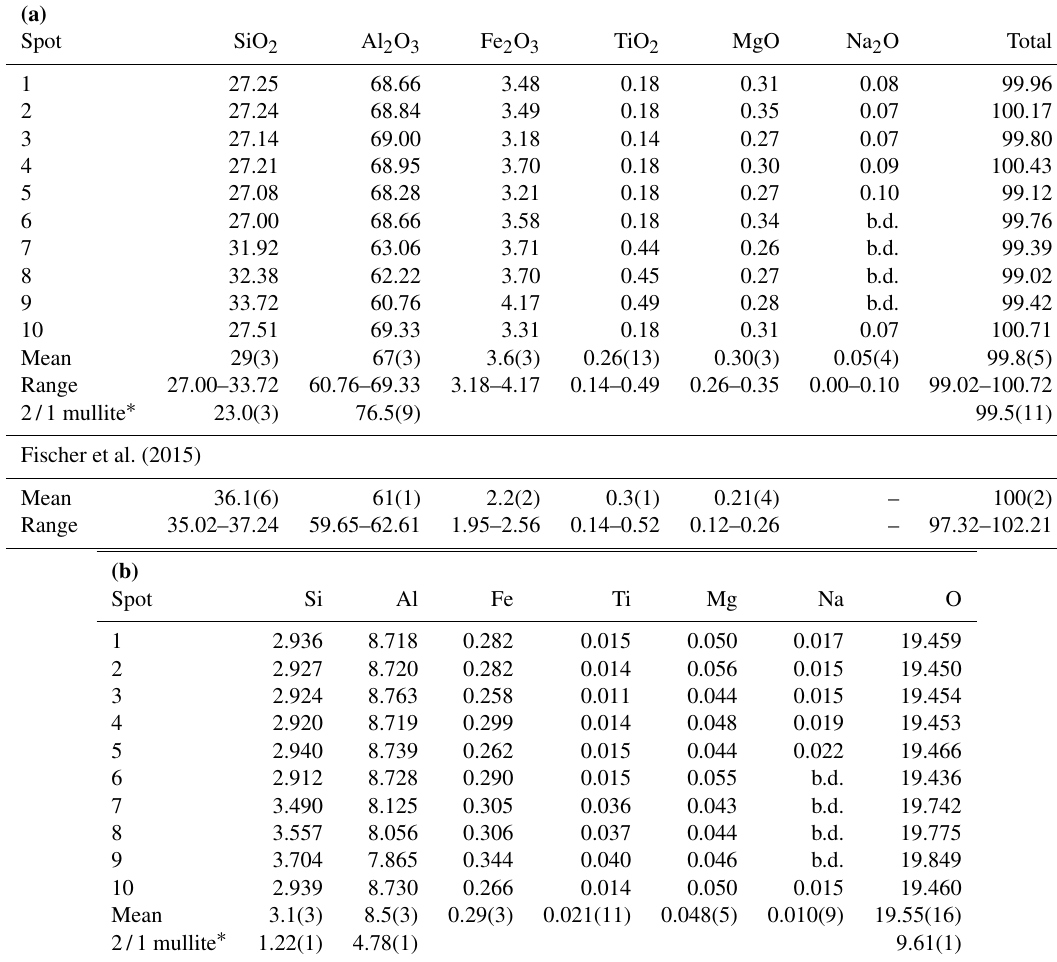
Table 2. (a) Electron microprobe analyses of mullite-2 c given in weight percent. (b) Electron microprobe analyses of mullite-2 c given in atoms per formula unit (apfu). Calculation corresponds to a normalisation of the sum of M 3 + , M 4 + and Mg 2 + to 12.